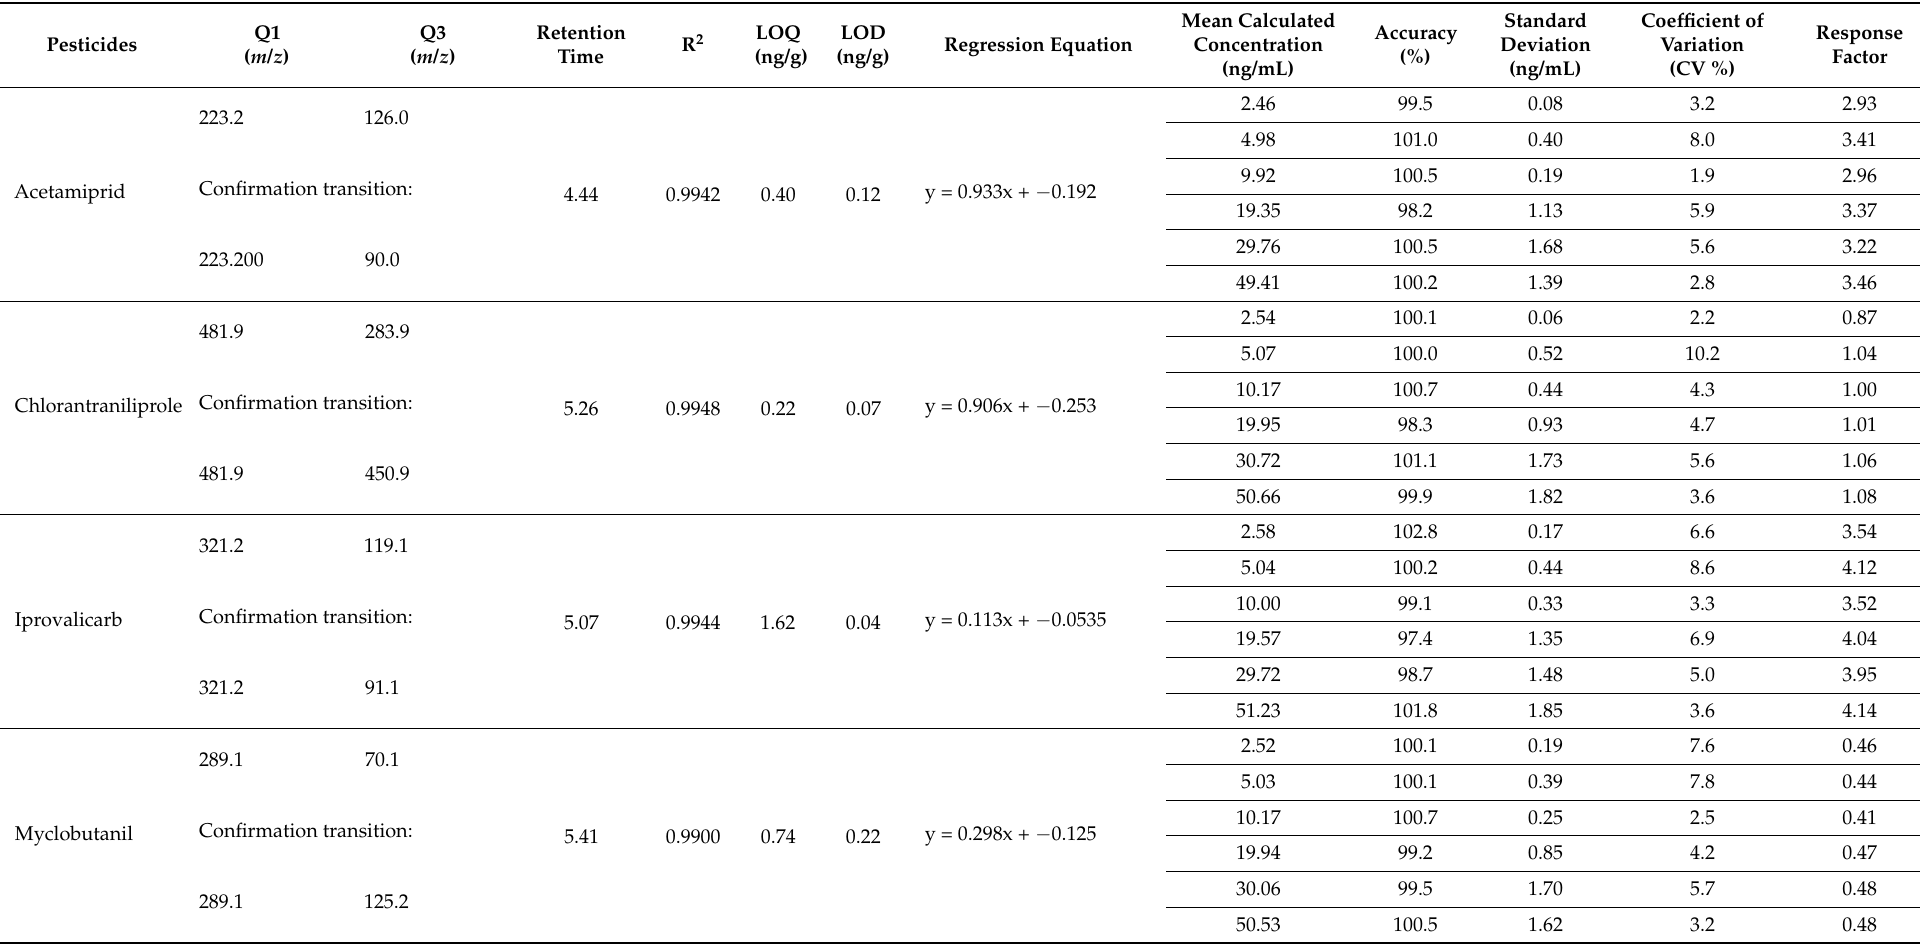
Table 2. The parameters for the analysis of the targeted pesticides in wine determined by